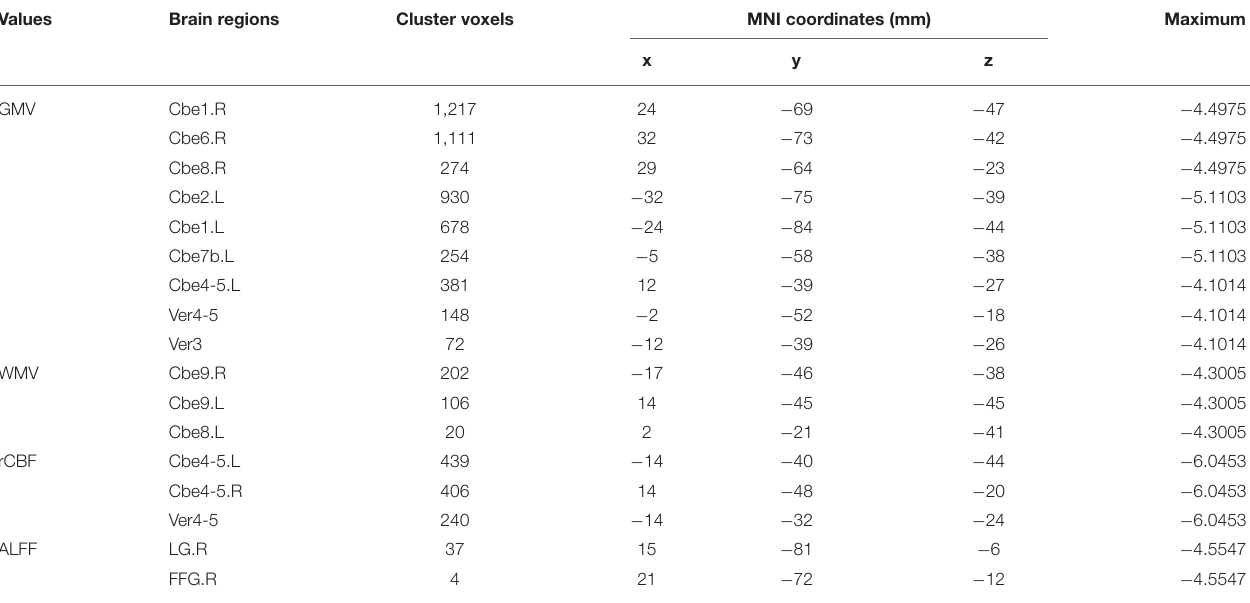
TABLE 2 | Structural, rCBF, and functional changes between the MSA-c and MSA-p patients. Values Brain